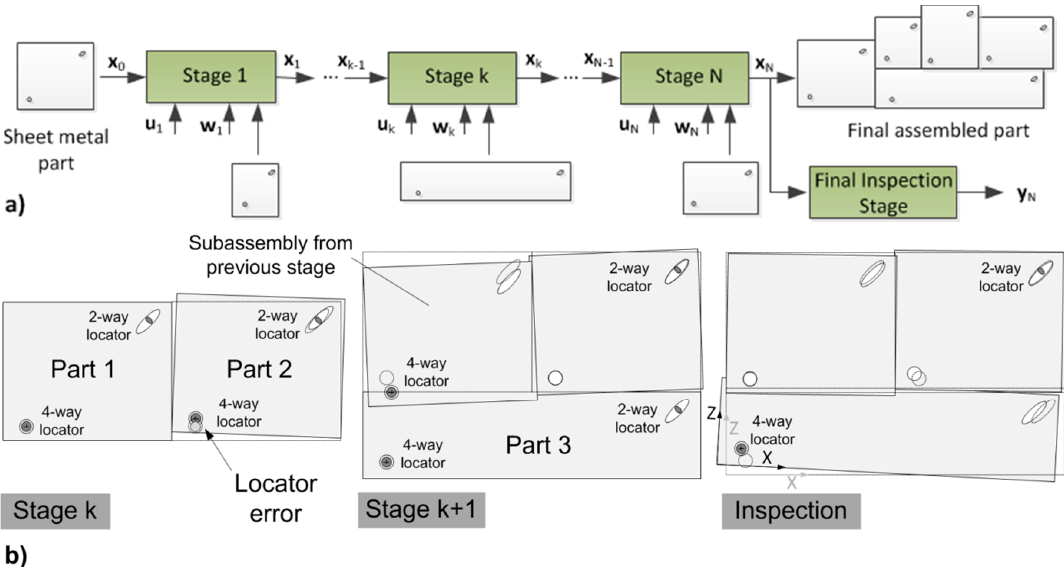
Figure 1. ( a ) Multistage assembly system (MAS) with N stations; ( b ) illustration of error propagation in a 2D MAS.